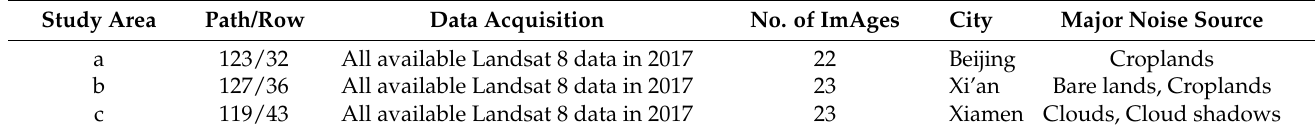
Figure 1. The locations of the three cities in China; a, b, and c represent Beijing, Xi’an, and Xiamen, respectively. Table 1. Information of the collected Landsat 8 OLI